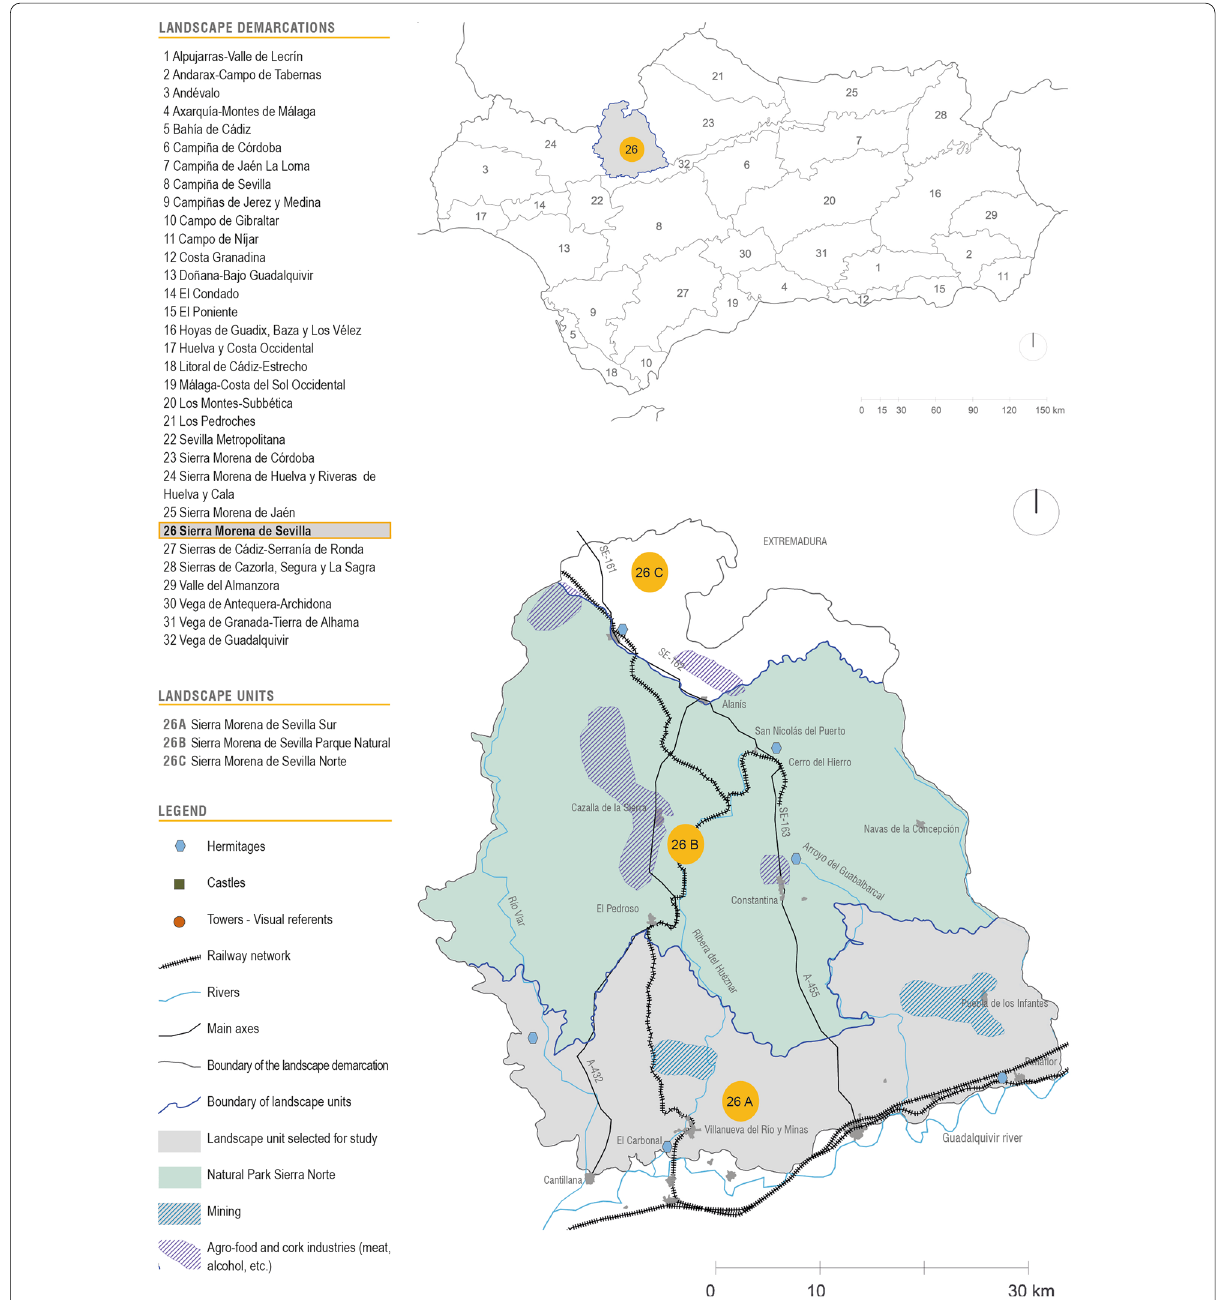
Fig. 2 Identification and delimitation of landscape units at different scales. Source: Own